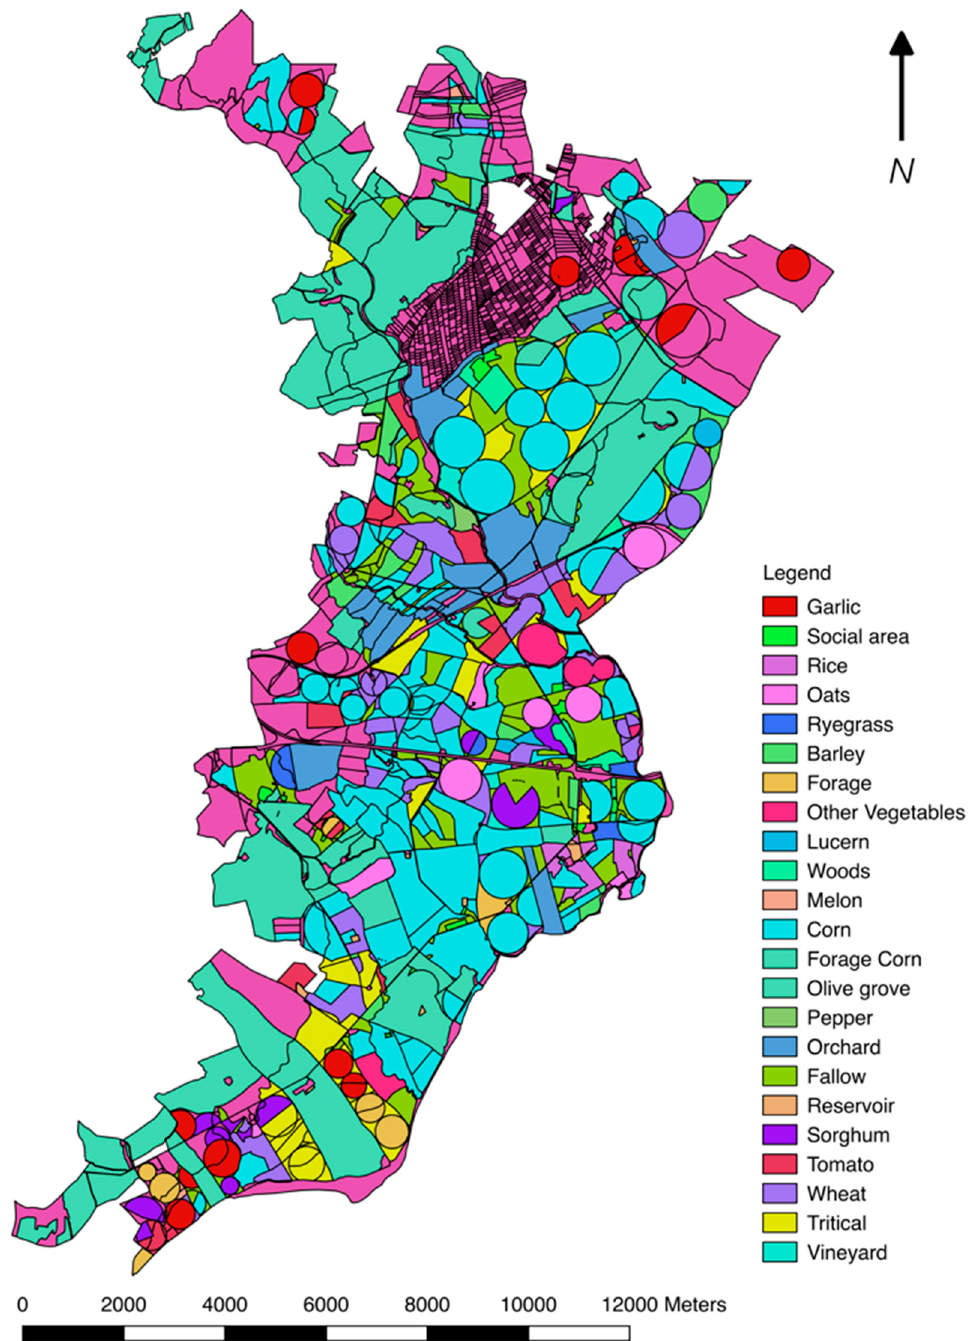
Figure 3. Typical crop distribution (data from 2012).